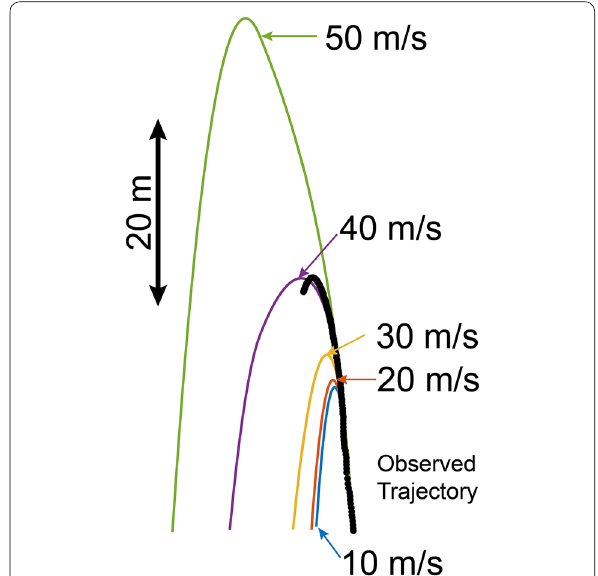
Fig. 5 One of the simulated trajectories of event 3 with varying flow velocities derived from a theoretical equation (Eq. 1). The input ejection velocities v x and v y are calculated based on the observed trajectory. A drag coefficient ( C D ) of 0.8 and a particle diameter of 20 cm are used. The mean drag coefficient value of 0.8 is based on the measurements of Alatorre-Ibargüengoitia and DelgadoGranados